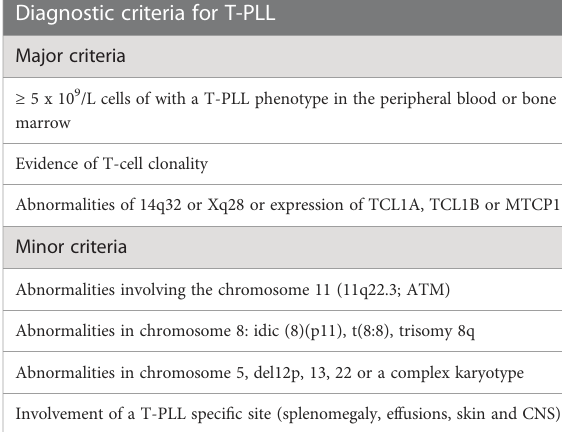
TABLE 2 Proposed diagnostic criteria for T-PLL by the T-PLL international study group (TPLL-ISG). Adapted from Staber et al. (10). Diagnostic criteria for